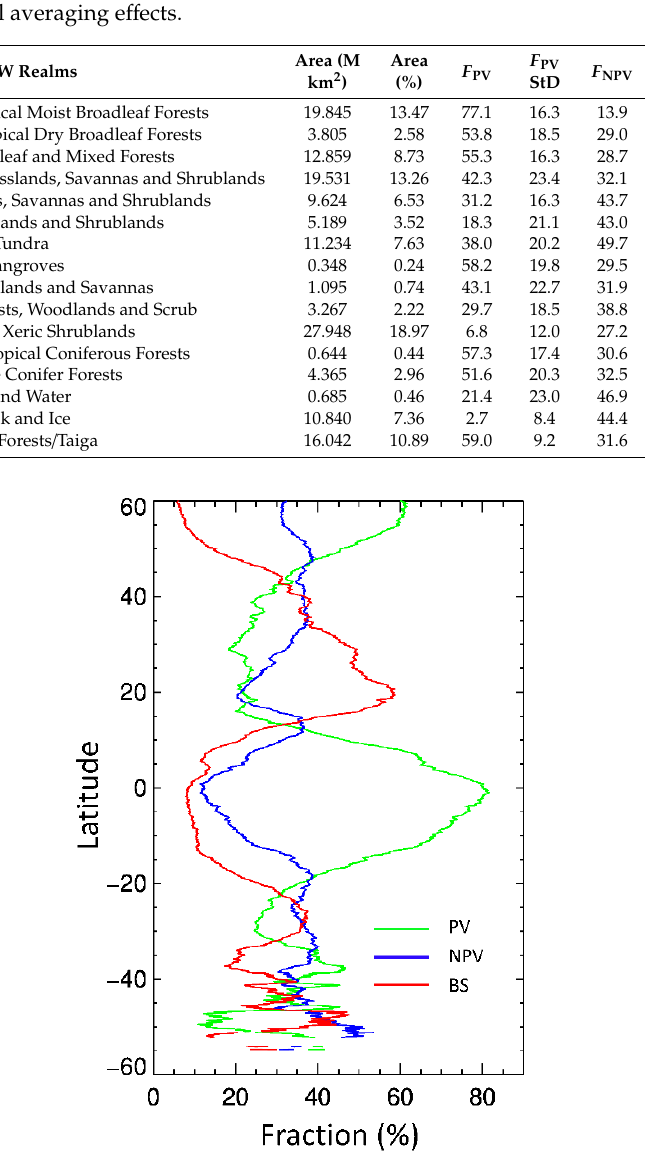
Figure 3. Global latitudinal variation in average fractional cover of F PV , F NPV , and F BS